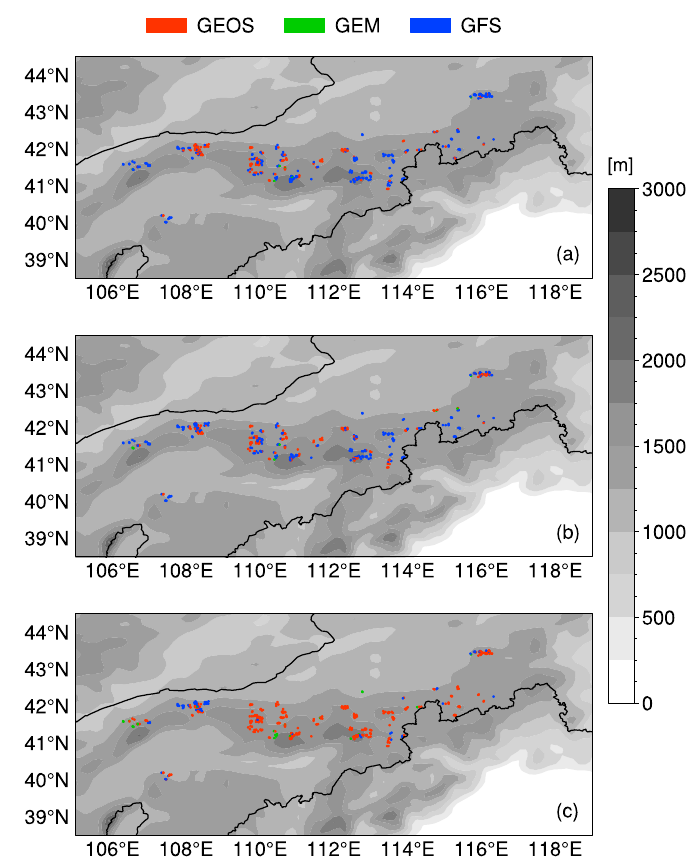
Figure 3. Distribution of the sites colored for the dominant best performing ensemble groups driven by the GFS, GEOS, and GEM forecasts: ( a ) correlation coefficients, ( b ) mean absolute errors, and ( c ) biases.